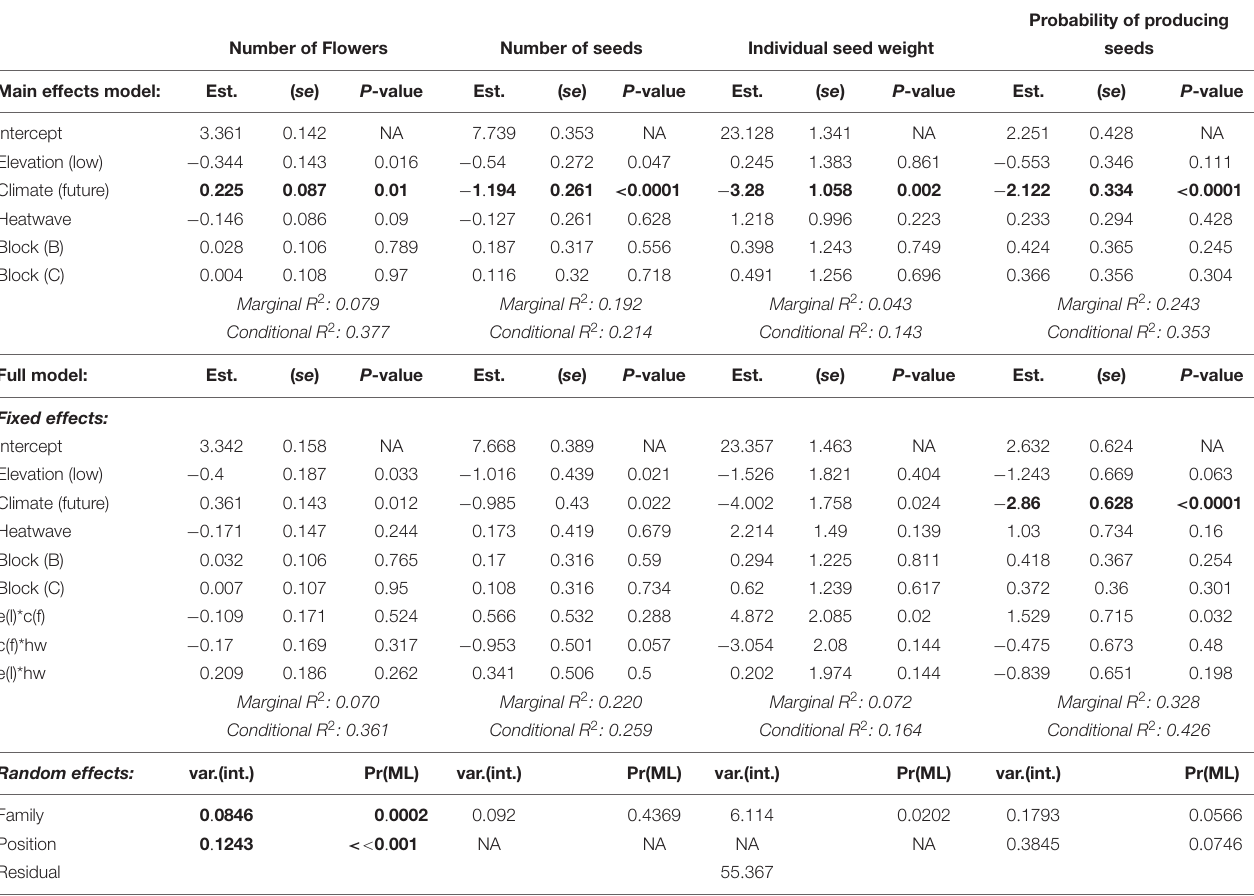
Probability of producing